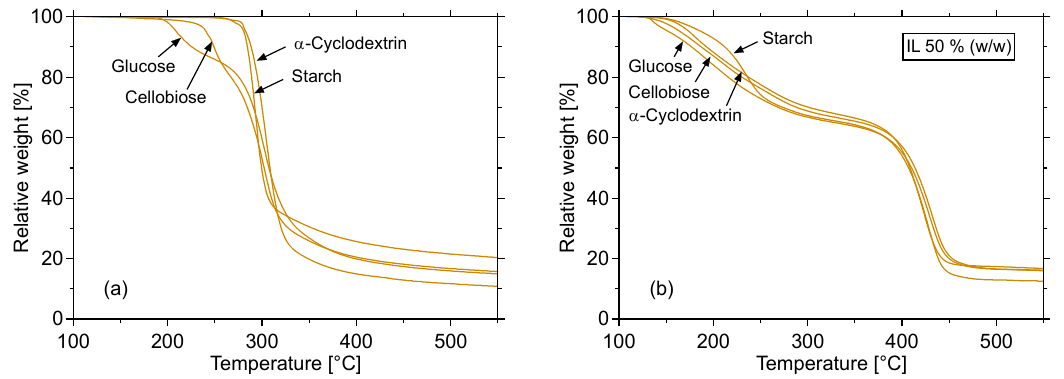
Figure 9. Weight loss curves of ( a ) glucose, cellobiose, α -cyclodextrin and starch and ( b ) their mixtures with [BMMIM]CF SO ; TGA under flowing nitrogen with 5 °C/min heating rate. 3 3